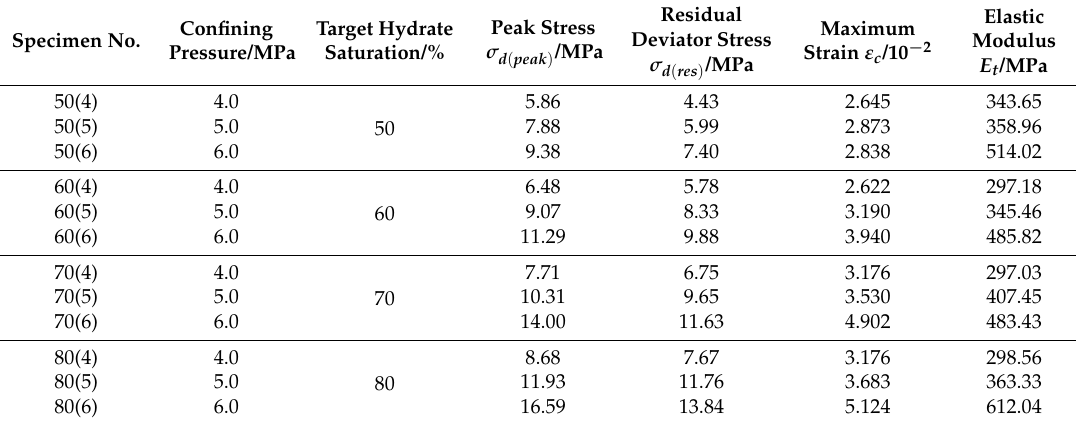
Table 3. Summary of results from triaxial compression